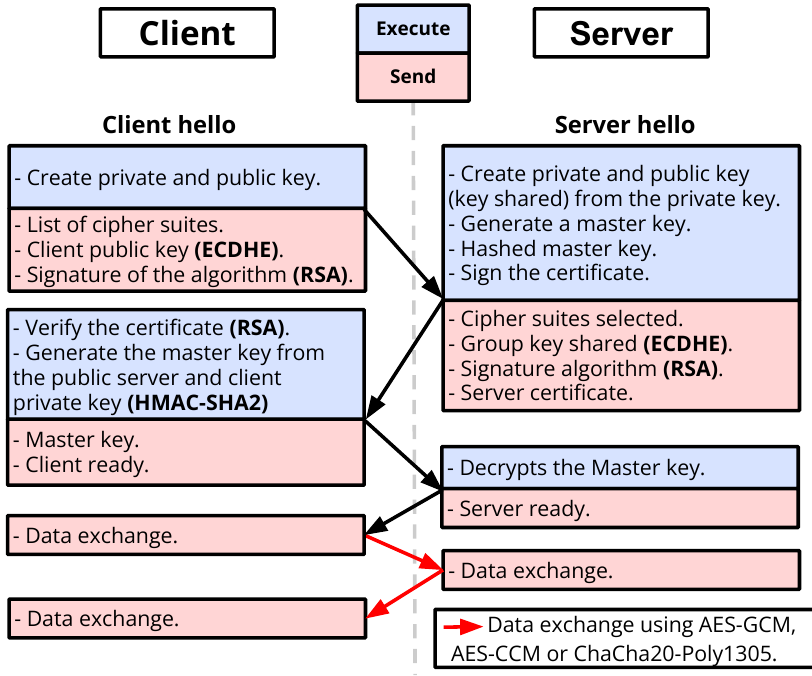
Figure 2. TransporT Layer Security 1.3 handshake protocol